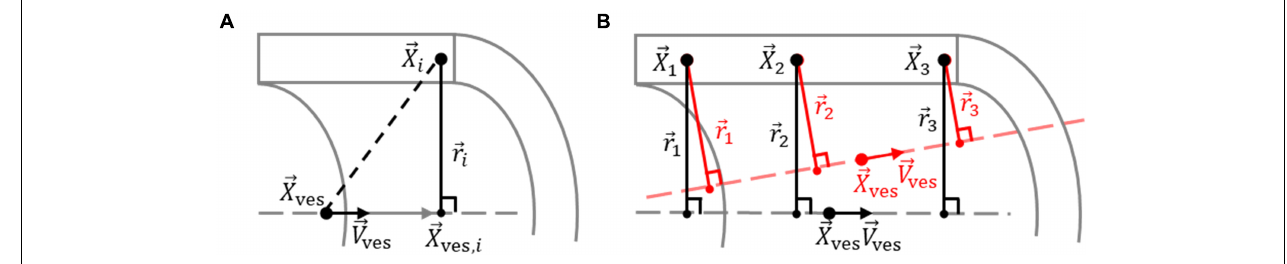
−→ X i , and the −→ X ves , i . (B) The optimum vessel